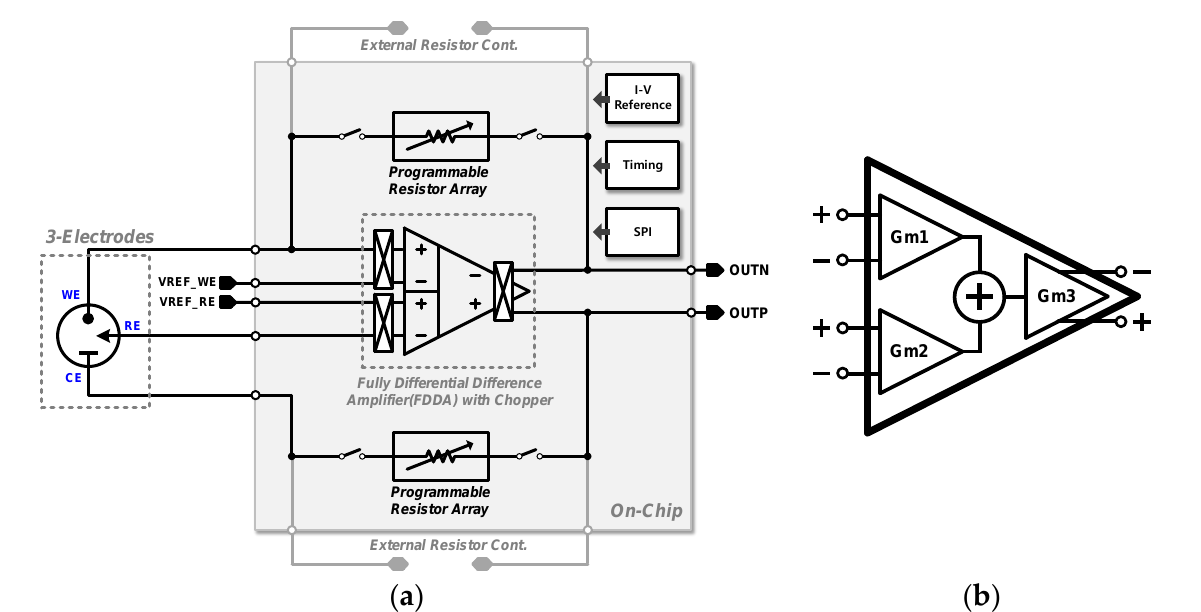
Figure 5. Potentiostat readout circuit: ( a ) top architecture and ( b ) FDDA current flow architecture.